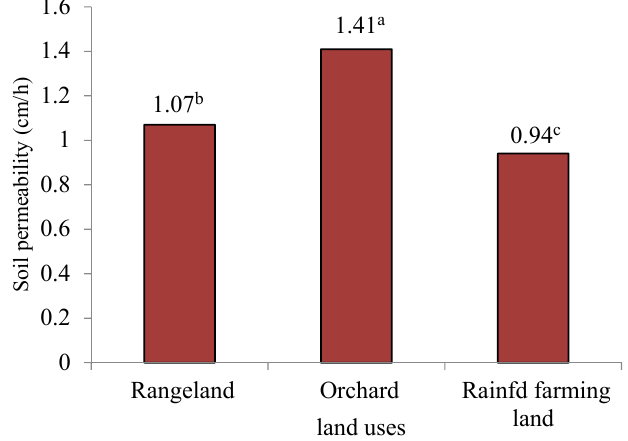
Fig. 4: Infiltration rate (cm/h) in the different land uses. Various letters indicate the meaningful difference (at probability=0.05) Table 4: The calculated USLE k-factors in various land uses Land use type